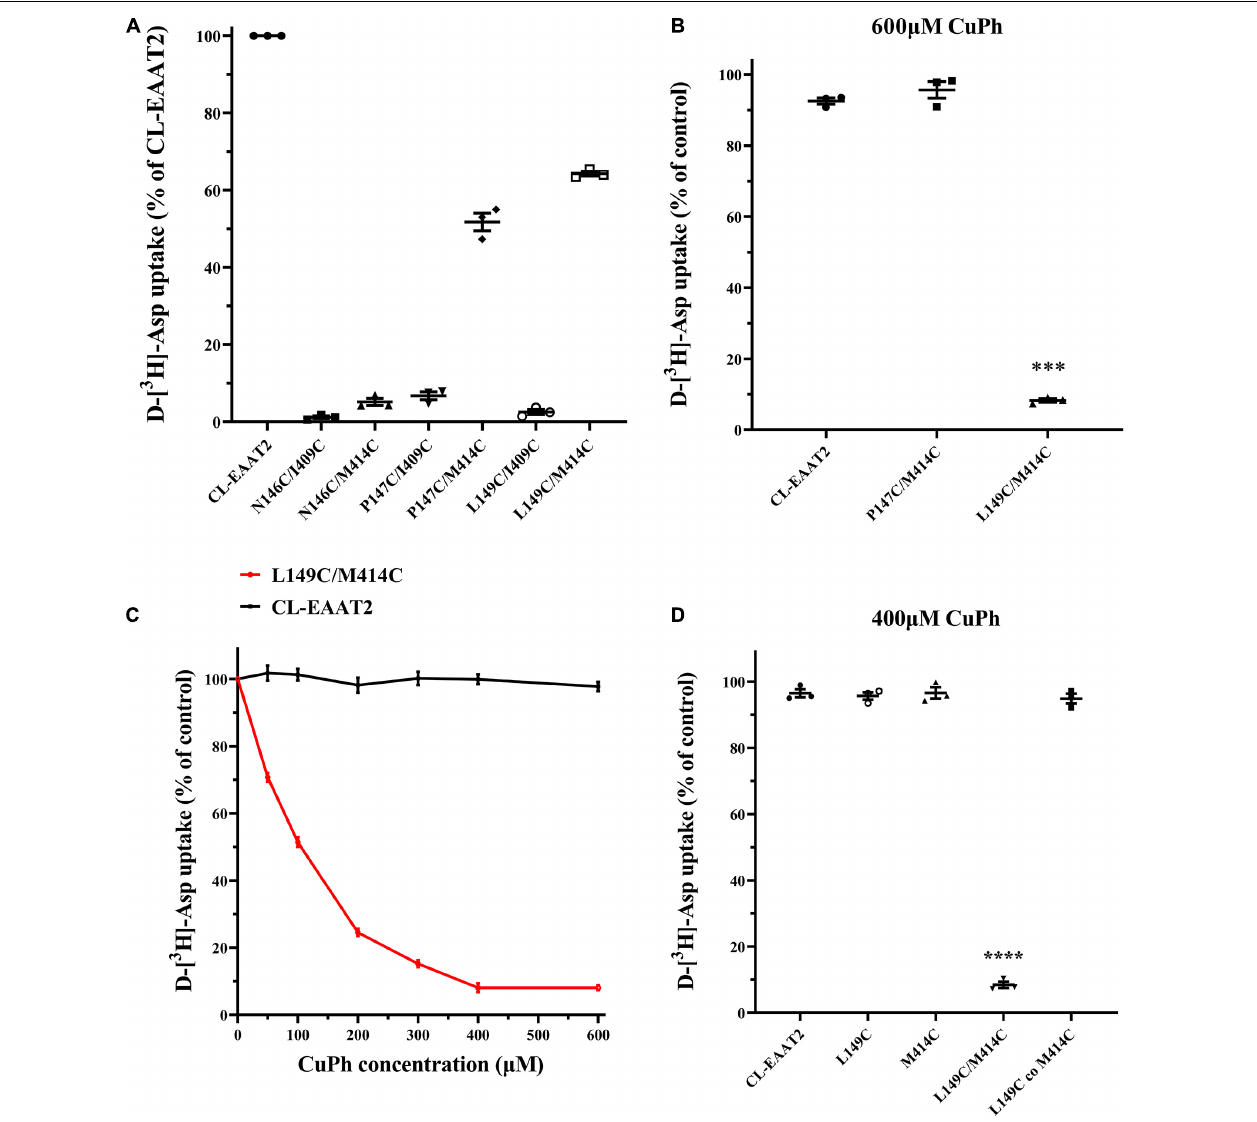
FIGURE 2 | Inhibition to D-[ 3 H]-Aspartate uptake of paired mutant L149C/M414C induced by CuPh. (A) Six paired residues on the TM3-TM4 loop and TM7 were replaced with cysteines. HeLa cells expressing the engineered cysteine mutants and cysless-EAAT2 (CL-EAAT2) were washed with choline chloride solution twice and incubated with radioactive labeled aspartate for 10 min. Transport activity of CL-EAAT2 and 6 various paired cysteine mutants were determined through the way of measuring D-[ 3 H]-aspartate uptake. (B) D-[ 3 H]-aspartate uptake was determined in CL-EAAT2, P147C/M414C and L149C/M414C with a pre-incubation of 600 µ m CuPh for 5 min followed by treatment with D-[ 3 H]-aspartate for 10 min. (C) D-[ 3 H]-aspartate uptake was determined in CL-EAAT2 and L149C/M414C pre-incubated in incremental concentrations of CuPh. (D) D-[ 3 H]-aspartate uptake was determined in CL-EAAT2, single cysteine mutants (L149C or M414C), and L149C/M414C paired cysteine mutant, and a co-transfection of L149C and M414C single mutants pre-incubated with 400 µ M CuPh. Transport activities upon incubation with CuPh are normalized separately for uptake in the absence of CuPh, apart from Figure (A) , which is normalized to activity of CL-EAAT2. Data are the means ± S.E. from at least three separate experiments in triplicate. Values significantly different from those of CL-EAAT2 were determined by one-way ANOVA (** *p < 0.001; *** *p < 0.0001; n = 3).